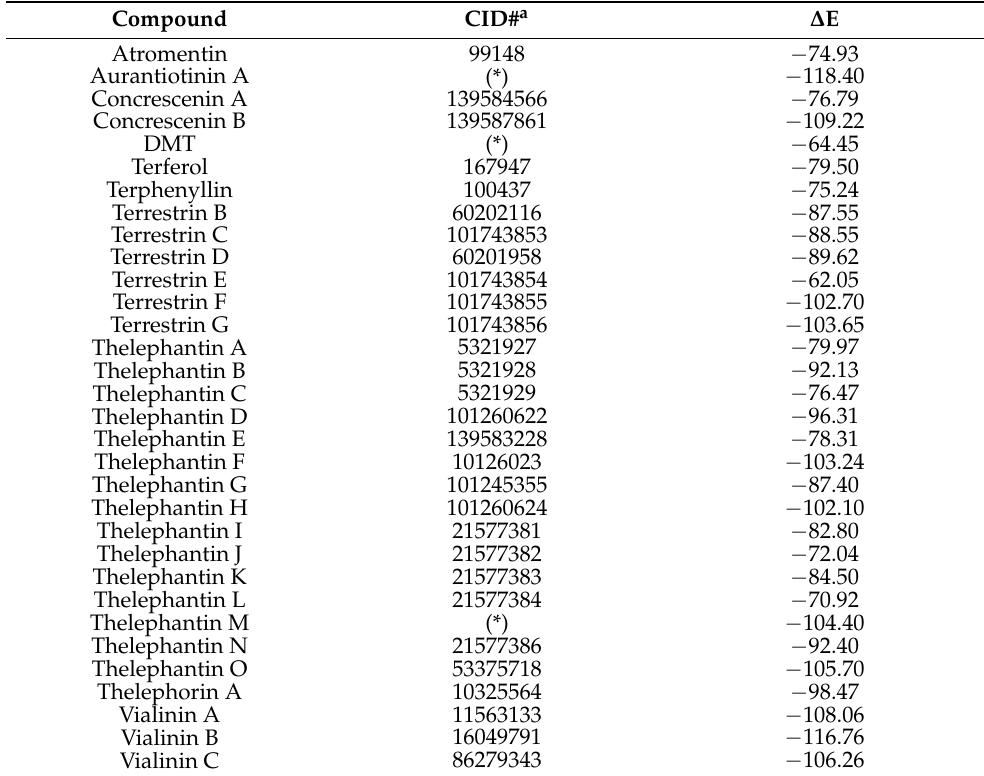
Table 1. Calculated potential energy of interaction ( ∆ E, kcal/mol) for the interaction of terphenyl compounds with USP4 (PDB: